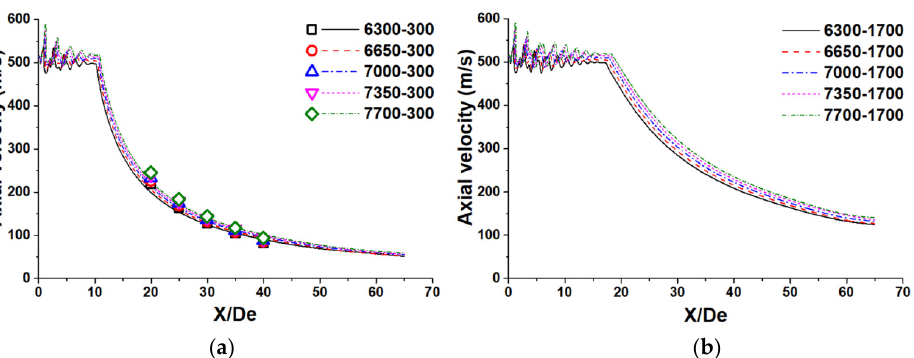
Figure 4. The axial velocity distribution of the supersonic jet at the Laval nozzle centerline: ( a ) room ambient temperature; ( b ) high ambient temperature.